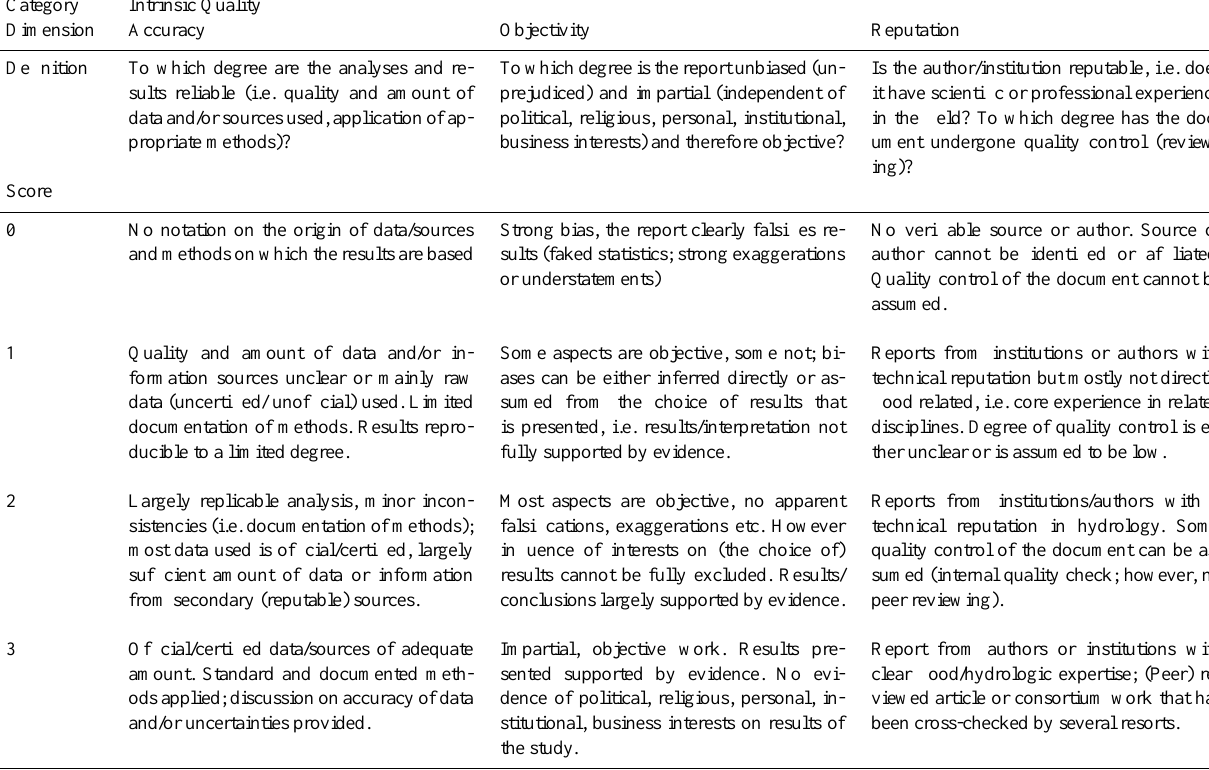
Table A3. Definitions of the quality dimensions and their respective scores for the “Intrinsic Quality” quality